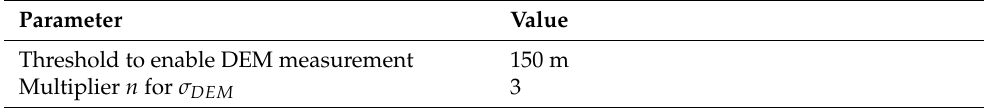
Table 8. DEM simulation parameters.